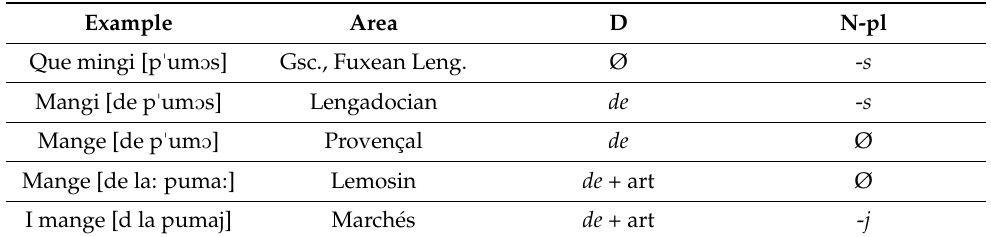
Table 7. Licensing of indefinite plurals vs. number morphology on Ns in Occitan varieties (data from Sauzet 2014, pp.